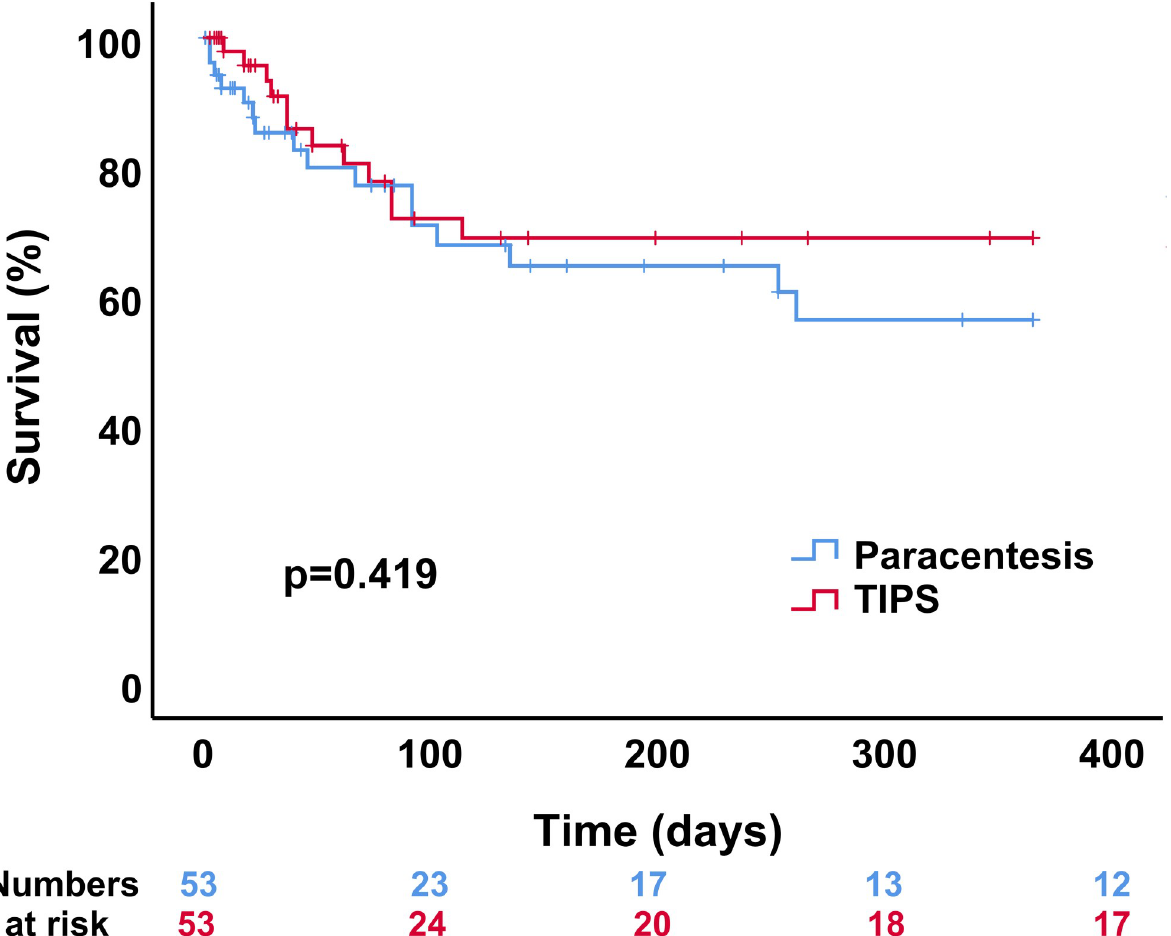
Fig 3. Comparison of 1-year survival between elderly cirrhotic TIPS patients and patients treated with paracentesis. The p -value was obtained using a stratified log-rank test and p < 0.05 was considered statistically